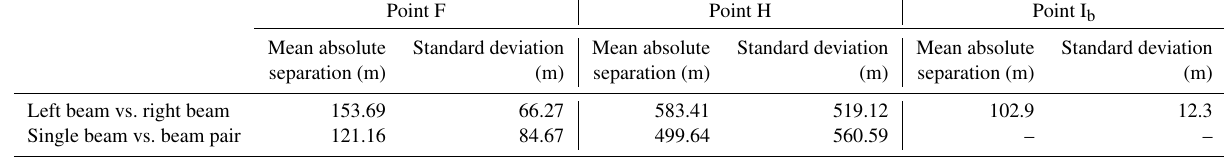
Left beam vs. right beam